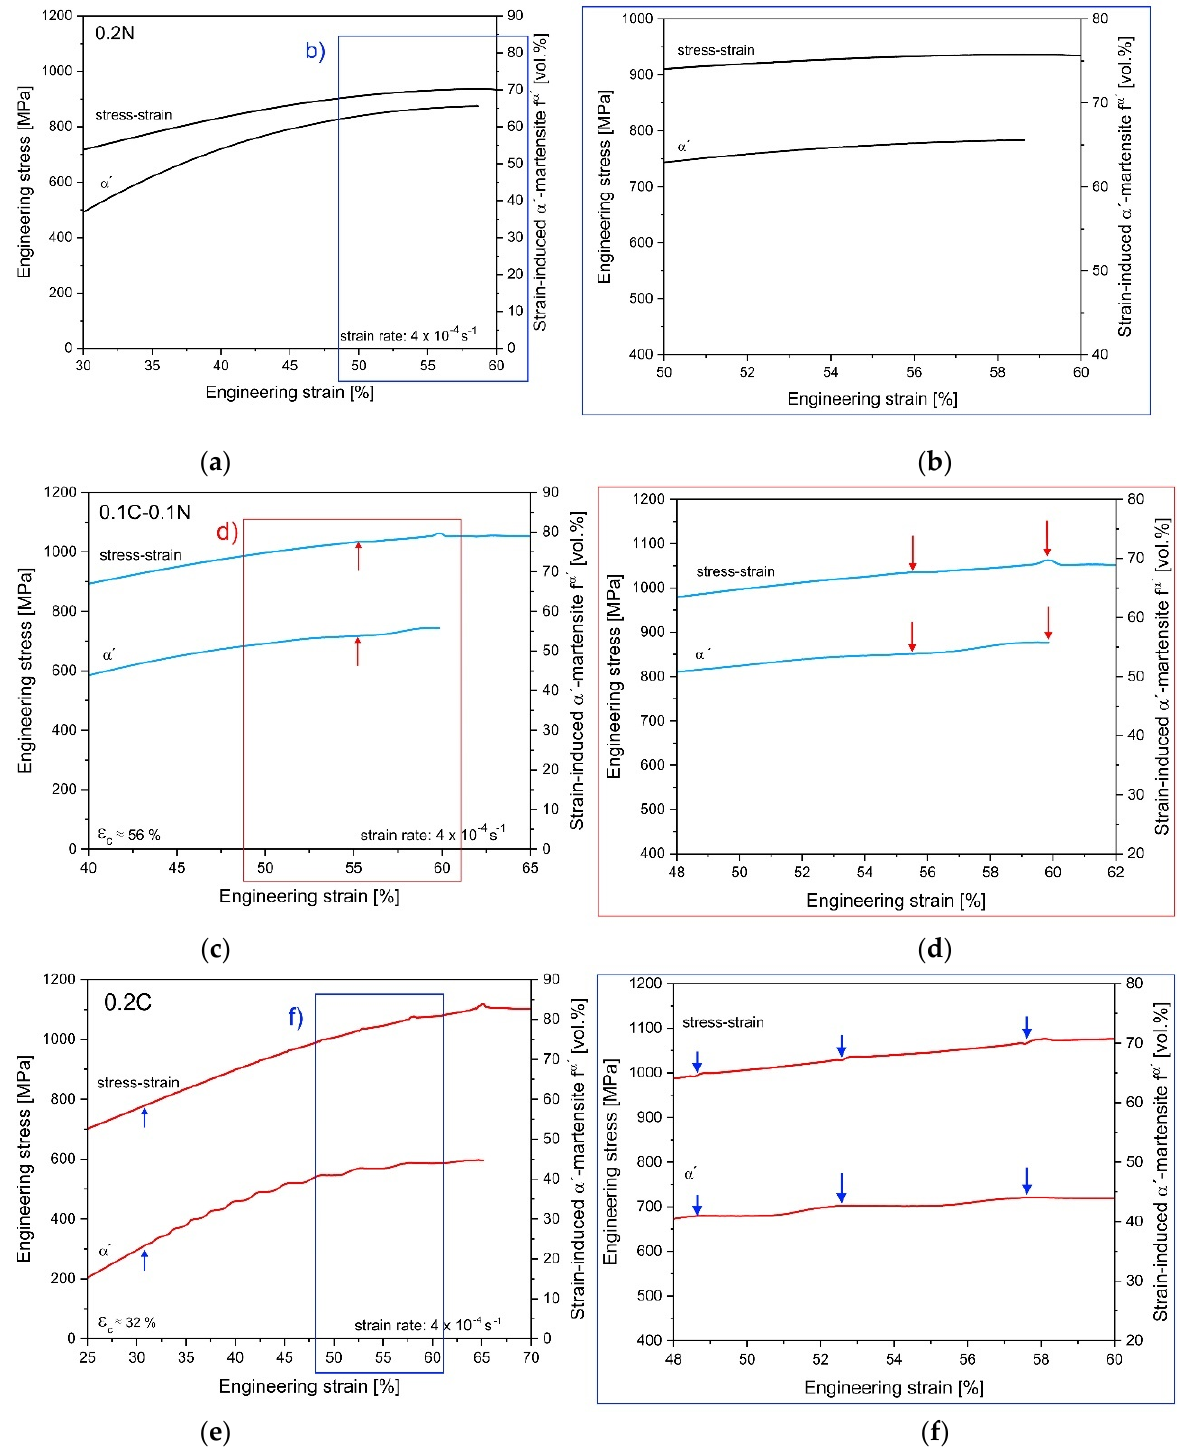
Figure 8. The stress–strain curve and strain-induced α ´-martensite evolution with DSA phenomena at RT: ( a , b ) 0.2N steel without DSA, ( c , d ) 0.1C-0.1N steel with DSA from 56% strain, and ( e , f ) 0.2C steel with DSA from 32% strain. In ( c , e ), the red and blue arrows indicate the critical strain for the onset of serrated flow. ( b , d , f ) give the magnification of the areas framed in ( a , c , e ).